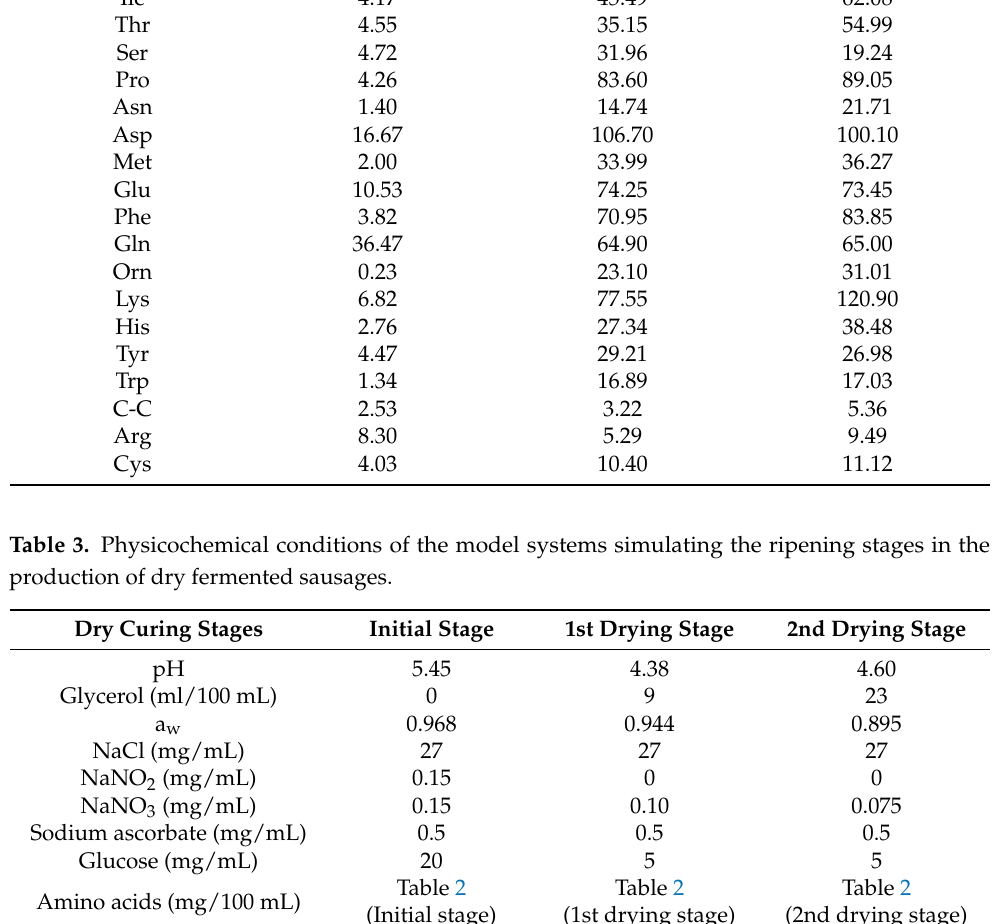
(Initial stage) (2nd drying